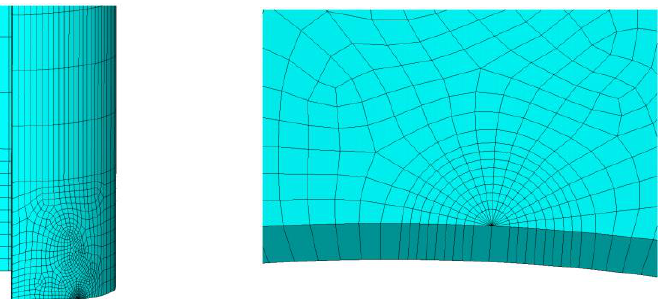
Figure 13. Finite element model of thin-walled cylindrical shell model with circumferential crack.